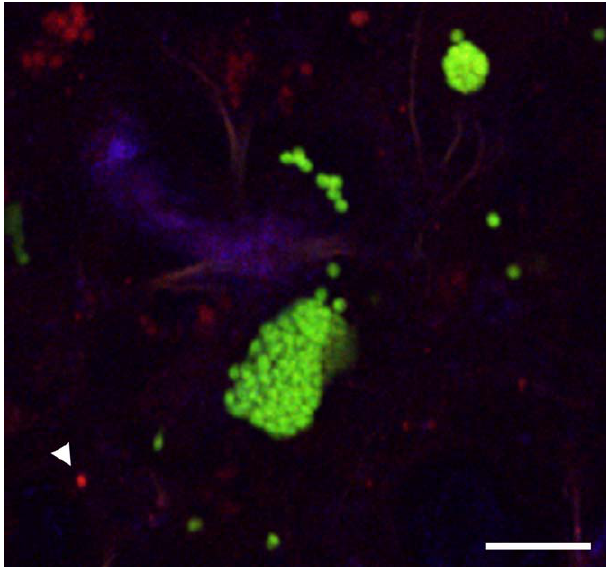
Figure 9. Pulmonary Merosomes Are Viable Mouse lung analyzed ex vivo 48 h after infection with PyGFP. Generally, neither merosomes nor free merozoites incorporated intravenously injected PI indicating that the parasites were viable. Note that one of the merozoites is PI-positive (arrowhead). Nuclei were visualized by Hoechst staining (blue). Bar ¼ 10 l m.